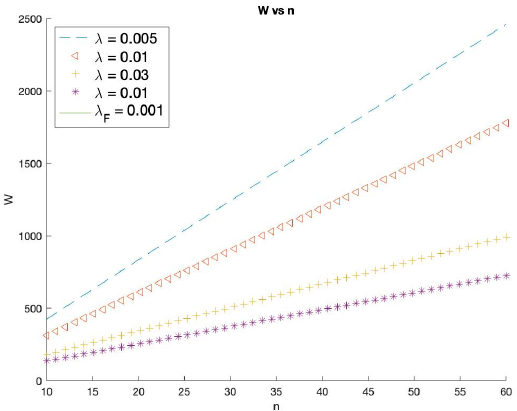
Figure 4. Average number of customers in the queue ( (cid:1838) (cid:3018) ) vs rate of slots ( (cid:2020) ).